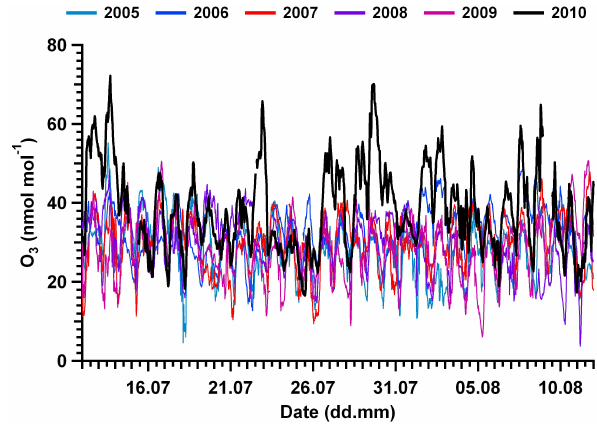
Fig. 2a. Temperature recorded in Hyyti¨al¨a between July and Au- gust from 2005–2010 from mast at 33.6m.